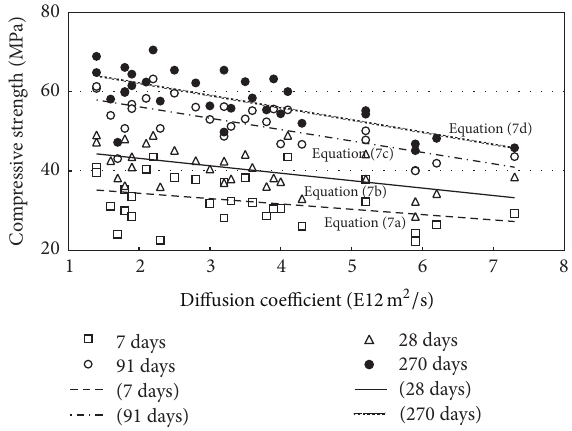
Figure 5: Relationship between compressive strength and diffusion coefficient.